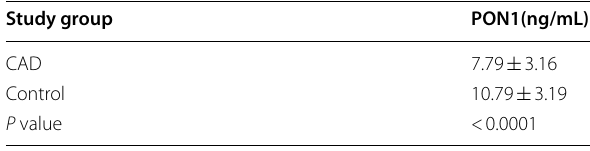
Table 2 Serum PON1 level in CAD and control group